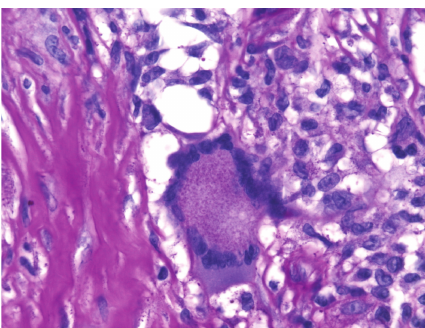
Figure 6: Hematoxylin-Eosin staining. A giant multinucleate cell, typical element of postoperative granuloma, is